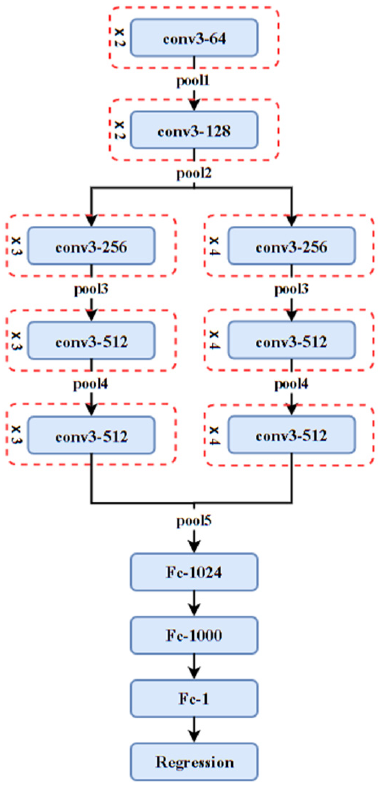
Figure 8. Diagram of the improved MVGG-19 network structure.